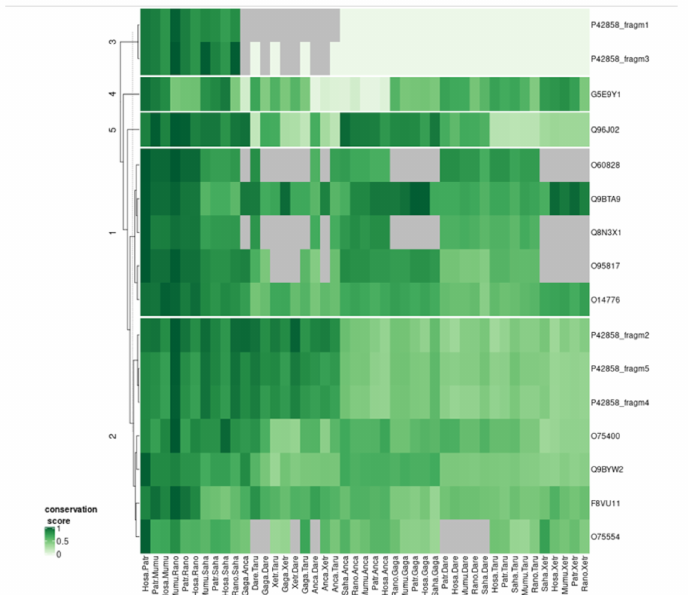
Figure 6. IDR co-evolution of WW proteins and HTT fragments. Each row represents the scores of overlap of the IDRs for each possible pair of orthologs for a given HTT interactor (UniProt ID) with WW domains, or for five fragments of HTT (P42858_fragm1/5). The data was hierarchically clustered. Five clusters are indicated. If one of the orthologs does not exist, a comparison is not possible and the corresponding cell is colored grey. If both sequences to be compared have no predicted IDRs, we consider the comparison not informative and the corresponding cell is also colored grey. Grey cells do not contribute to the clustering. See the Methods section for details. The heatmap was produced with the R package complex heatmap [38]. The values represented in the heatmap are available as Supplementary File